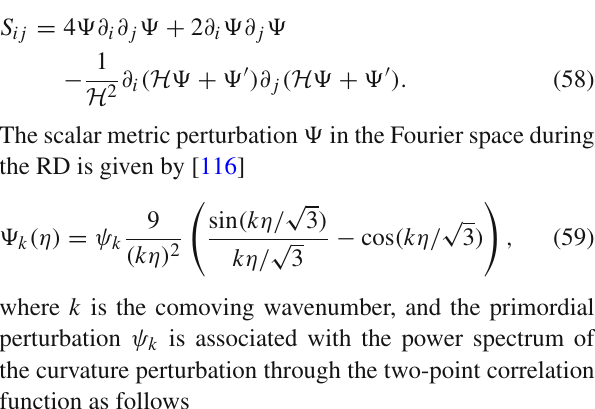
Fig. 5 The PBHs abundance ( f PBH ) in terms of PBHs mass ( M ) for Case A (purple line), Case B (green line), Case C (red line), Case D (blue line), and Case F (brown line). The purple area depicts the restric- tion on CMB from signature of spherical accretion of PBHs inside halos [99]. The border of the red shaded domain depicts the upper bound on the PBH abundance ensued from the LIGO-VIRGO event consolidation rate [100–103]. The brown shadowy domain portrays the authorized region for PBH abundance owing to the ultrashort-timescale